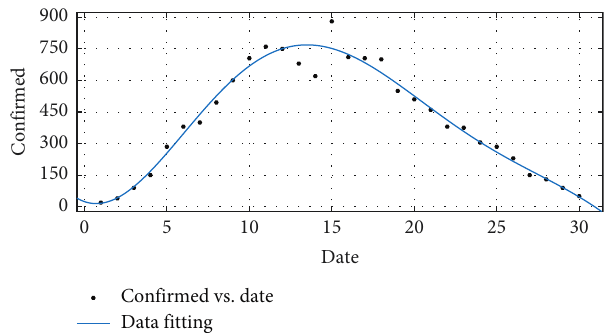
Figure 16: Date fitting by ploy